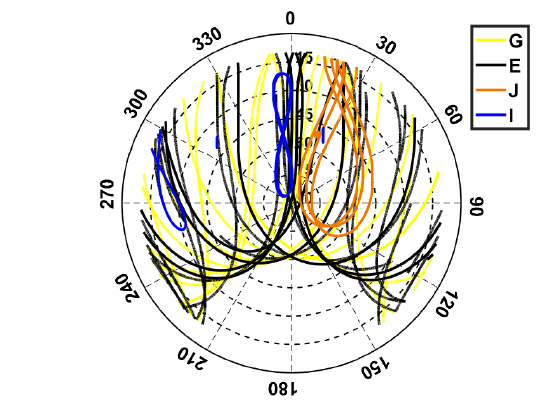
Figure 3. Skyplot for station CUAA on DOY 224, 2018. An elevation mask of 10 degrees was set for the